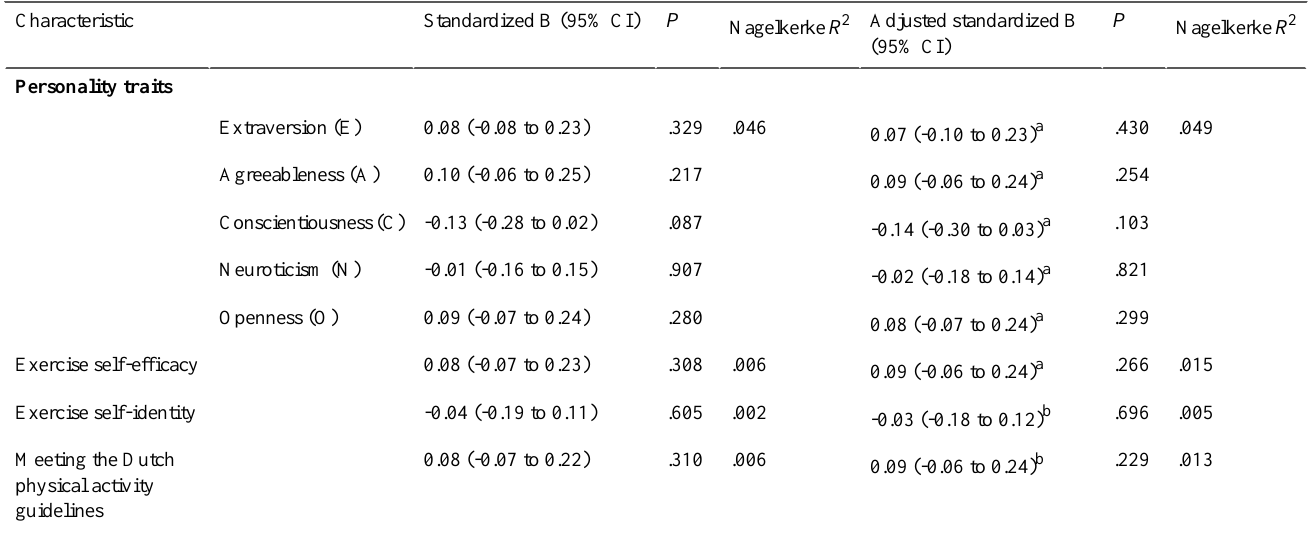
Table 6. Association between personality characteristics and preference for behavior change techniques addressing social support and social